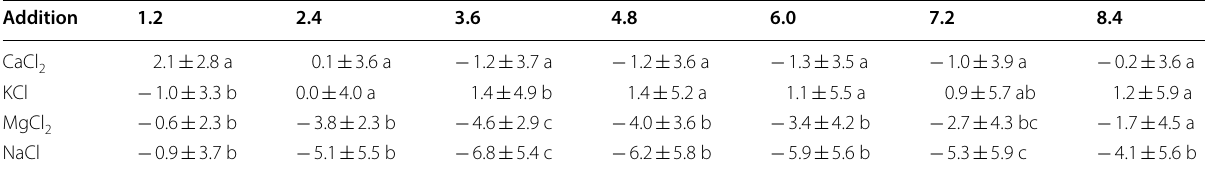
Table 4 Difference in O (without